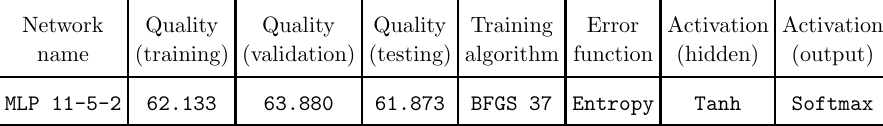
Table 3. Characteristics of the selected artificial neural network